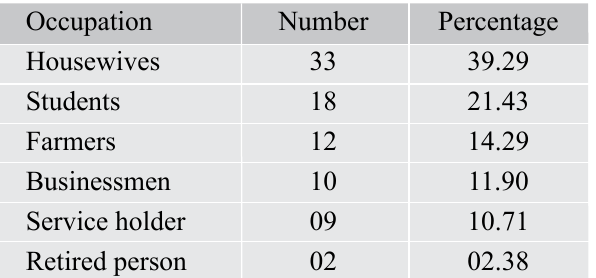
Table II: Distribution of subjects according to